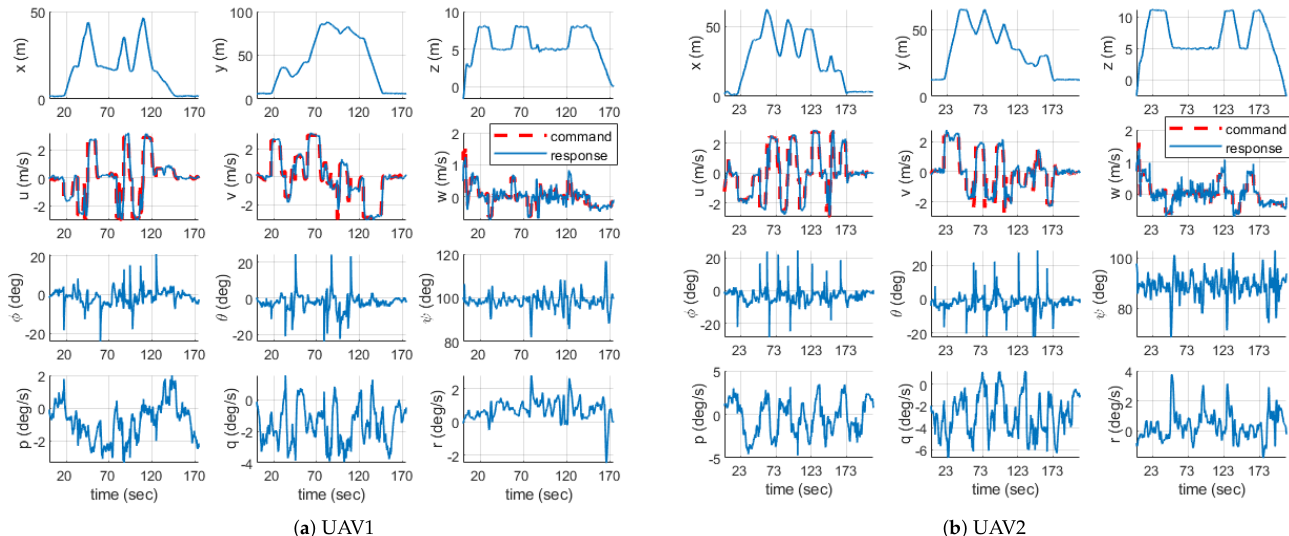
Figure 16. Time histories of